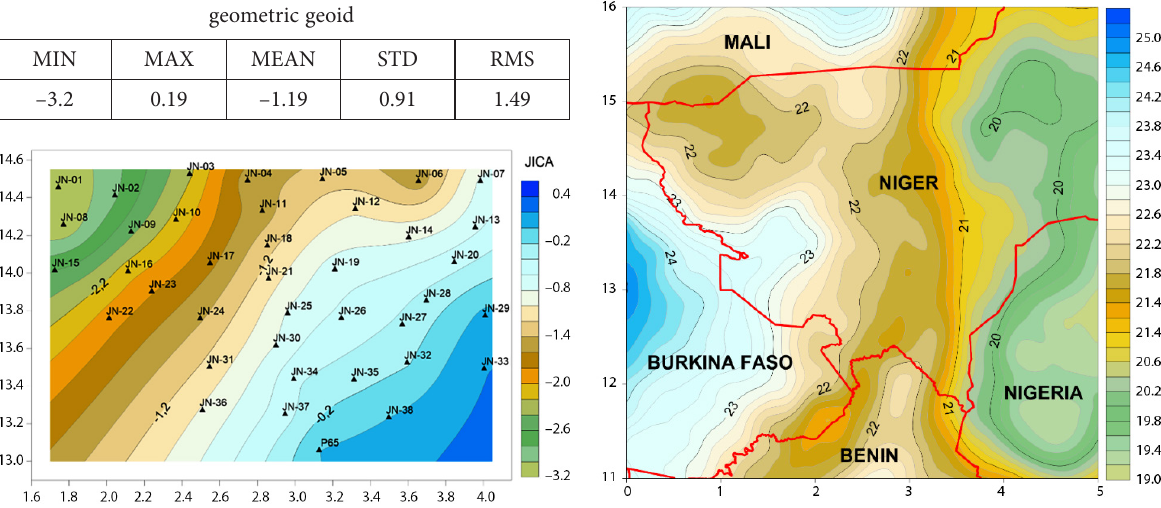
Fig. 5. Geoid Undulations from EGM2008 at d/o 2190. Source : Ibrahim Yahaya et al.